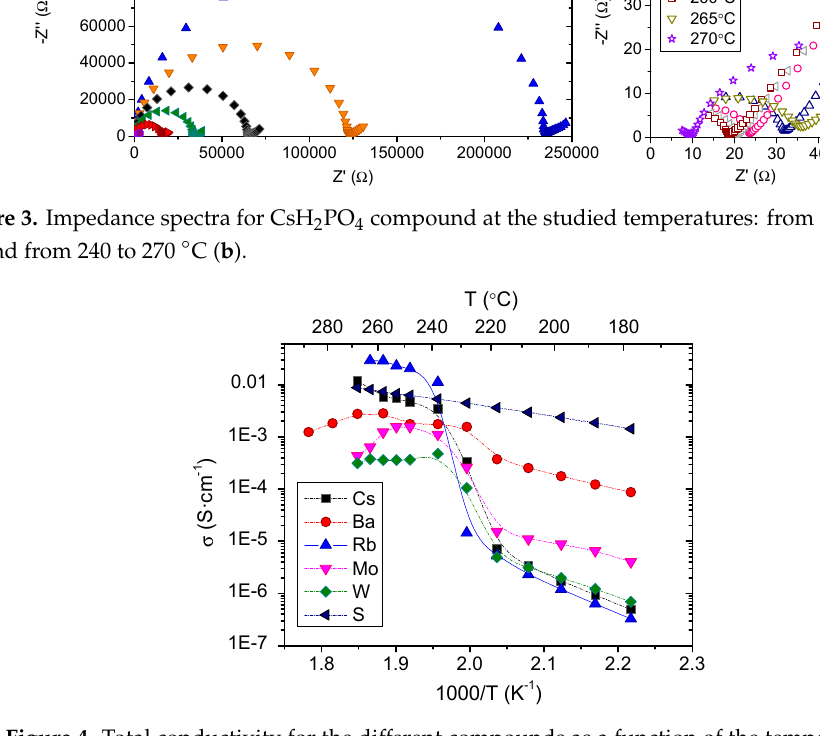
Figure 4. Total conductivity for the different compounds as a function of the temperature.